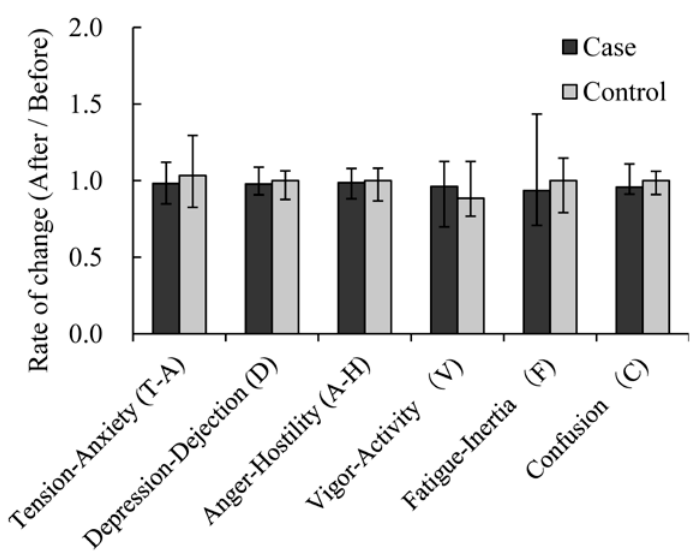
Figure 8. Profile of Mood States.